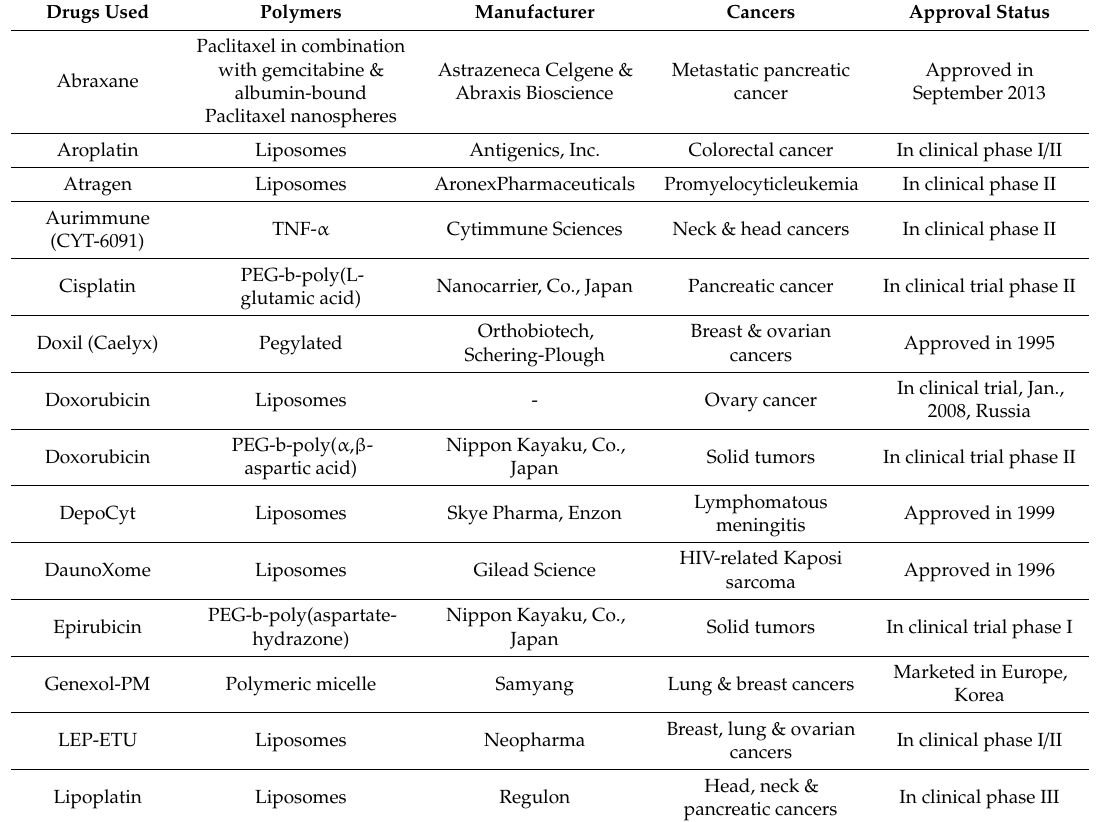
Table 7. The approved polymeric nanomedicines for the cancer